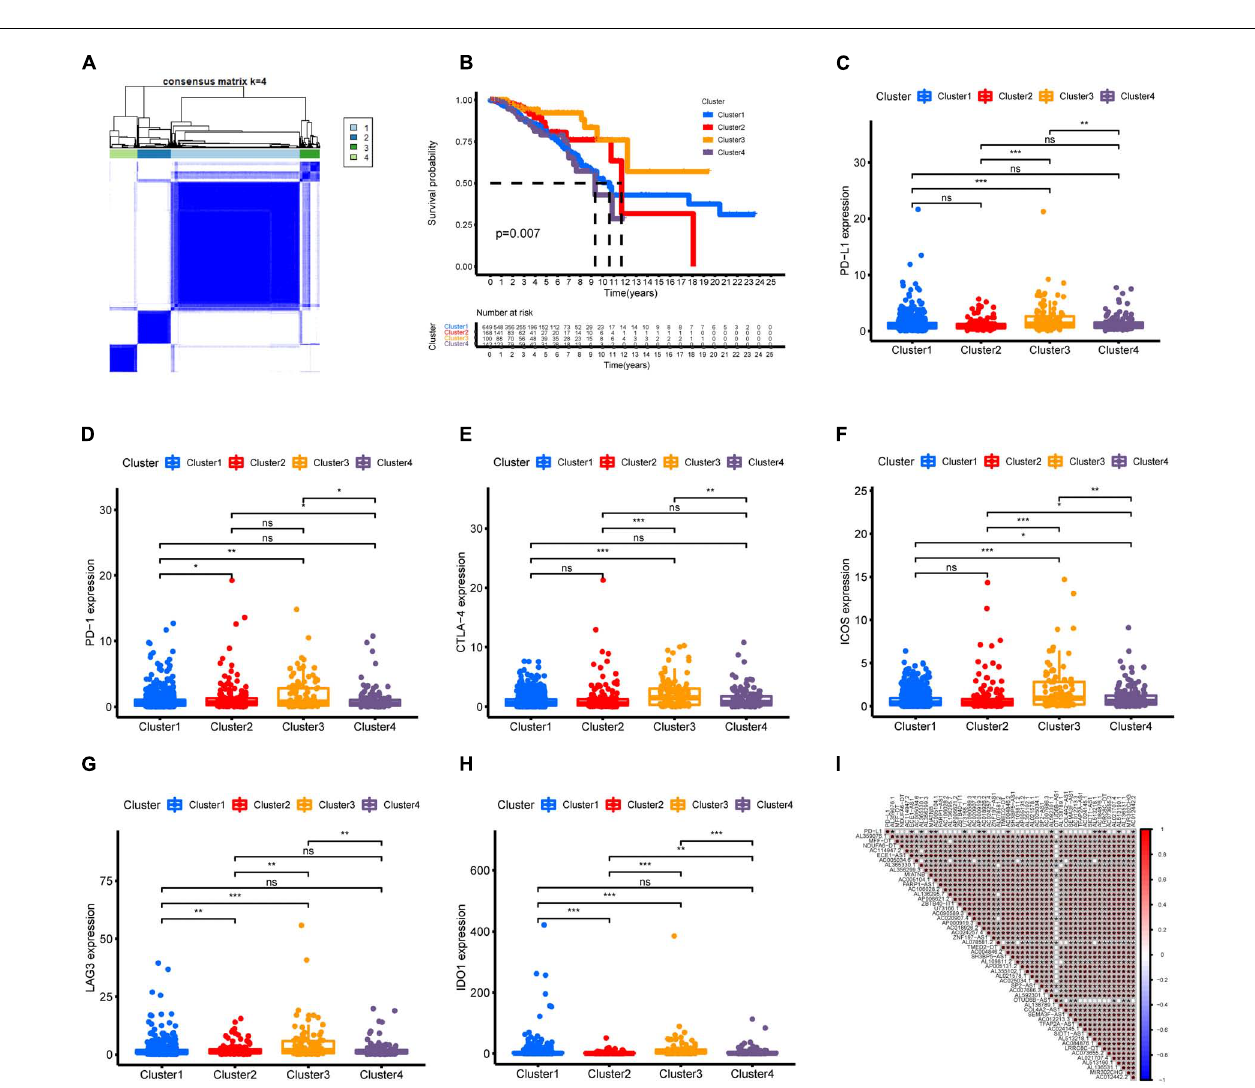
FIGURE 2 | Consensus clustering of m6A-related lncRNAs and immune checkpoint member expression in different BC subtypes. (A) Consensus clustering matrix for k = 4. (B) Kaplan–Meier curves of OS for four clusters in TCGA-BRCA. ( C–H) The expression of immune checkpoints PD-L1, PD-1, CTLA-4, ICOS, LAG3, and IDO1 in different BC subtypes. (I) Association of PD-L1 and 51 prognostic m6A-related lncRNAs was determined using Spearman correlation analysis. ns, no significance; * p < 0.05; ** p < 0.01; and *** p < 0.001.